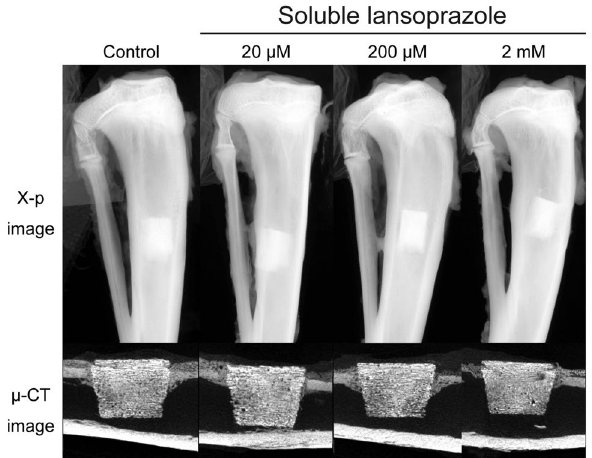
Figure 4. Radiographic and µ-CT images of soluble lansoprazole-impregnated artificial bones embedded for four weeks in a rabbit cortical bone defect model. In contrast to insoluble-lansoprazole ones (Fig. 1), experimental materials appeared to fuse with the host